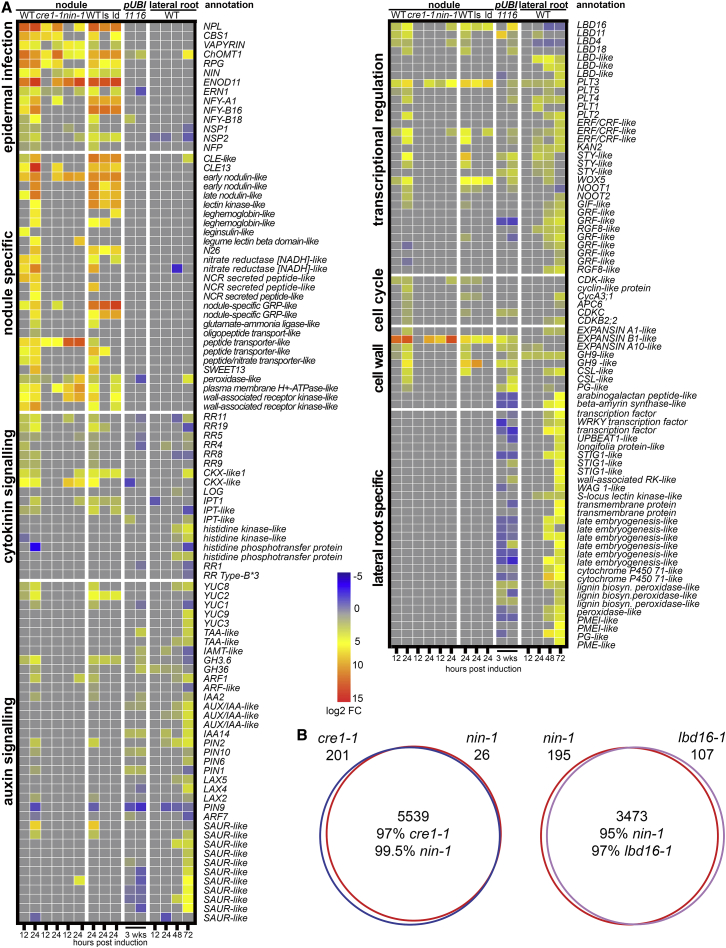
The Impact of CRE1, NIN, and LBD16 on Nodulation-Associated Gene Expression(A) Heatmap of selected genes (as in Figure 2; see also Figure S2 for gene identifiers and Data S1) in WT (jemalong), cre1-1, and nin-1 root sections at 12 and 24 h and WT (R108), lbd16-1 (ls), and lbd11lbd16 (ld) at 24 h post S. meliloti spot inoculation; response to LBD11 (11) and LBD16 (16) overexpression in 3-week-old hairy roots compared to control roots and during lateral root induction. Expression represents log2 fold changes.(B) Pairwise comparisons of all differentially expressed genes dependent on cre1-1 (blue), nin-1 (red), and lbd16-1 (purple). cre1-1 and nin-1 comparisons were to WT jemalong and lbd16-1 to WT R108.See also Figures 2, S2, and S5 and Data S1.